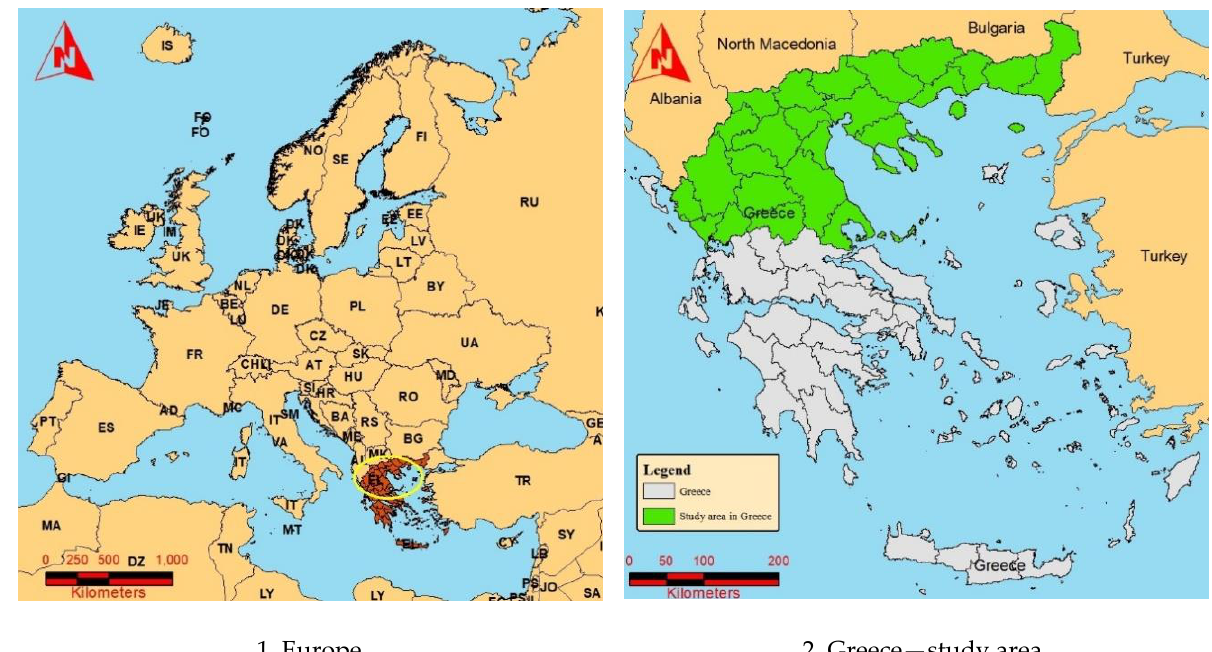
Figure 3. Maps of Europe and Greece. Source: Authors ’ own work (2022).